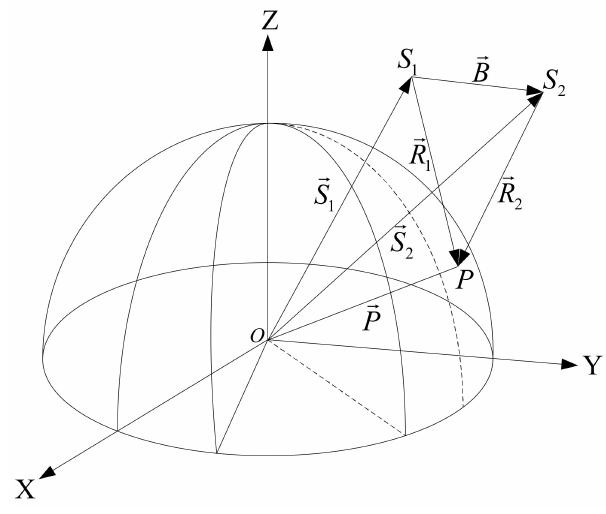
Figure 1. Geometric relationships of the spaceborne